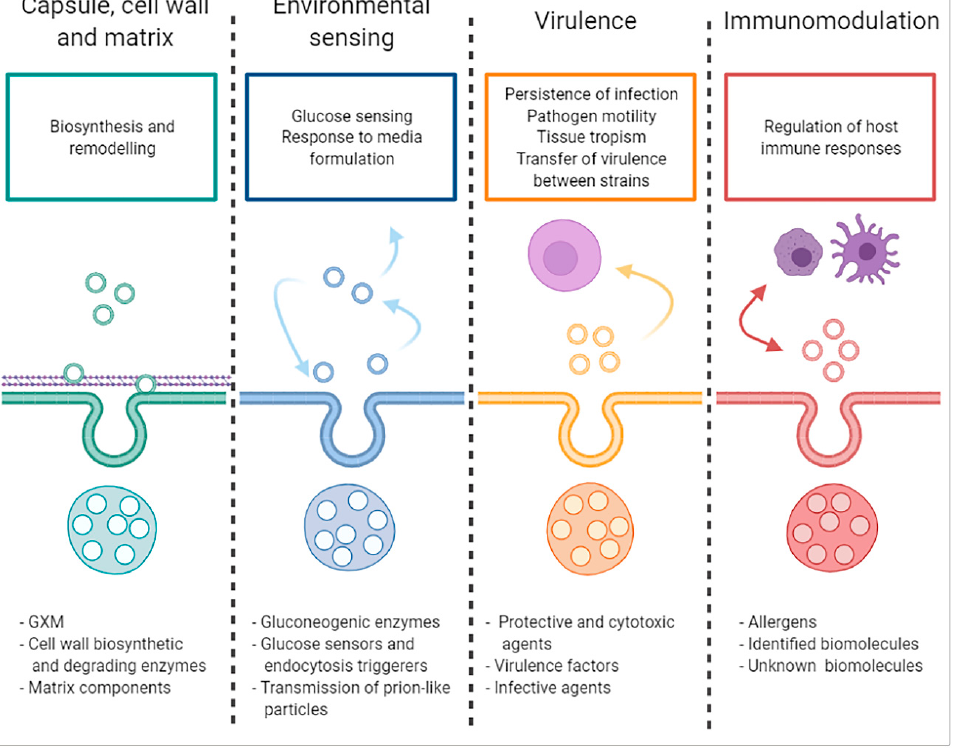
Figure 3. Functions of fungal EVs. Descriptions of the functions (Capsule, cell wall and matrix synthesis; Environmental sensing; Virulence and Immunomodulation) are shown at the top of the figure and the corresponding responsible EV components at the